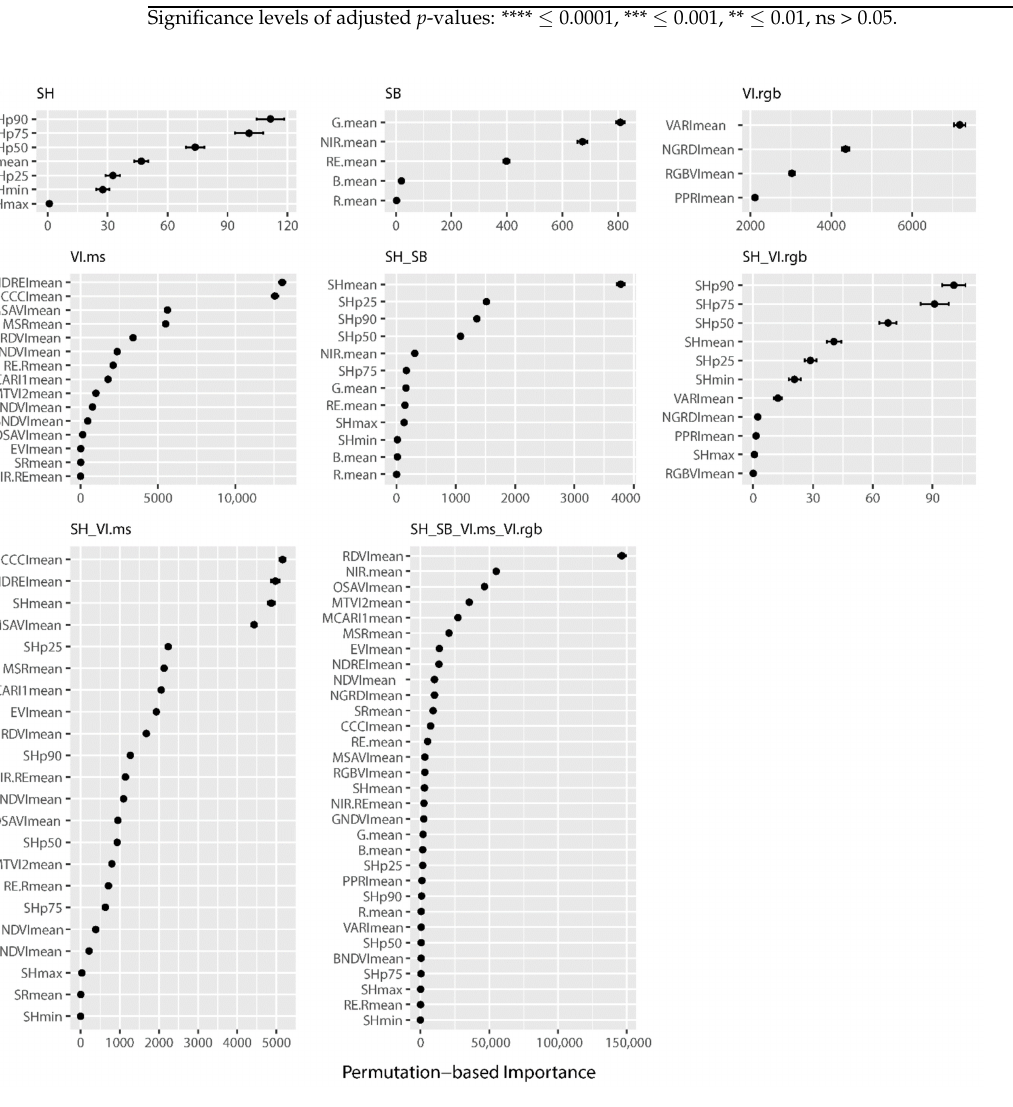
Figure A1. VIP of DMY estimation with